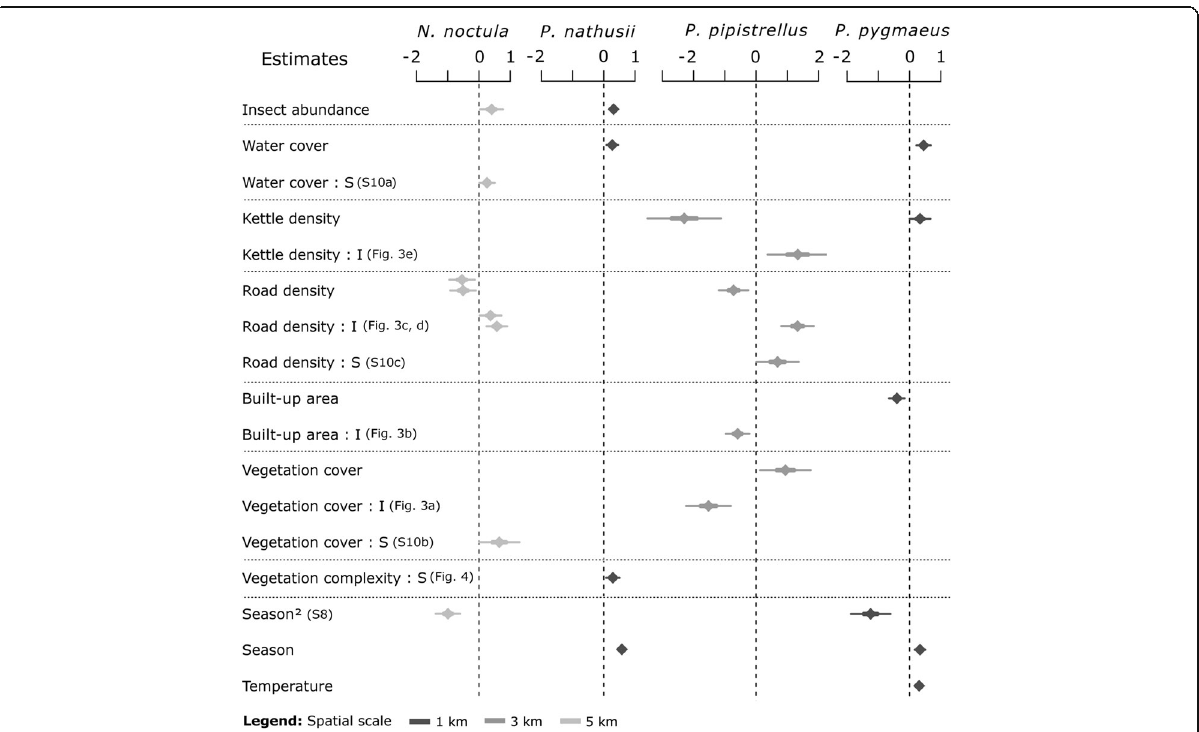
Fig. 2 Estimates of factors derived from previously selected models which shape the relative activity of Nyctalus noctula , Pipistrellus nathusii , P. pipistrellus , and P. pygmaeus . Bat activity was modeled as a proportion of minutes with bat calls and the total number of minutes in a given night on a site (logit link). Interactions between landscape characteristics and either insect abundance ( I ) or season ( S ) are indicated by